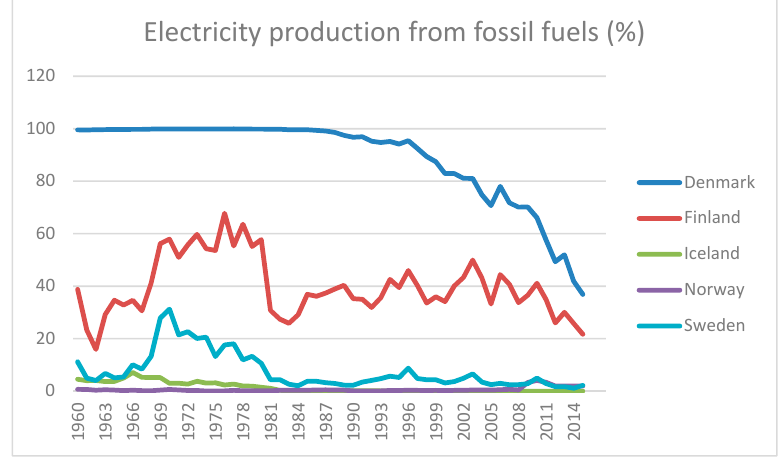
Figure 4. Share of fossil fuels as percentage of total energy use, by the Nordic countries between 1960 and 2015. Data source: [44].